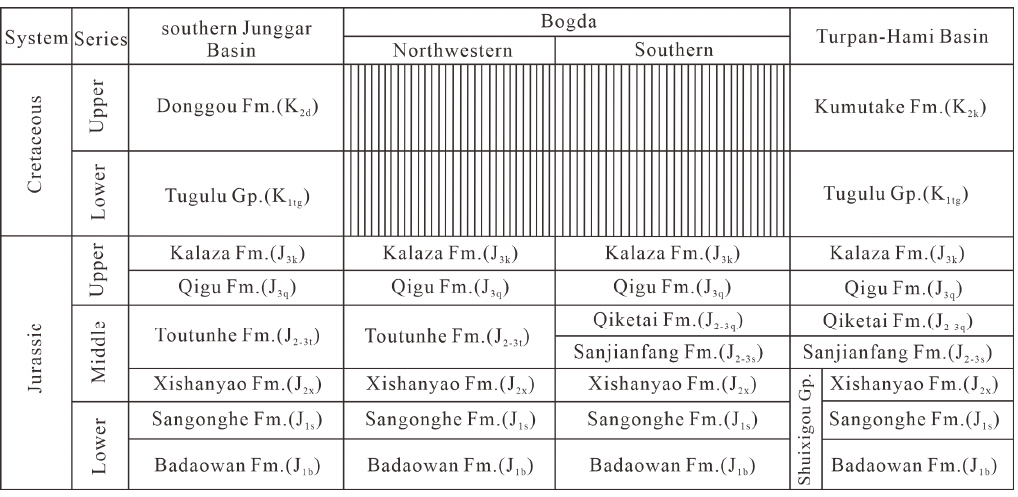
Figure 2. Chronostratigraphic correlation diagram for the Jurassic–Cretaceous strata from the south- ern Junggar basin, Bogda, and Turpan-Hami